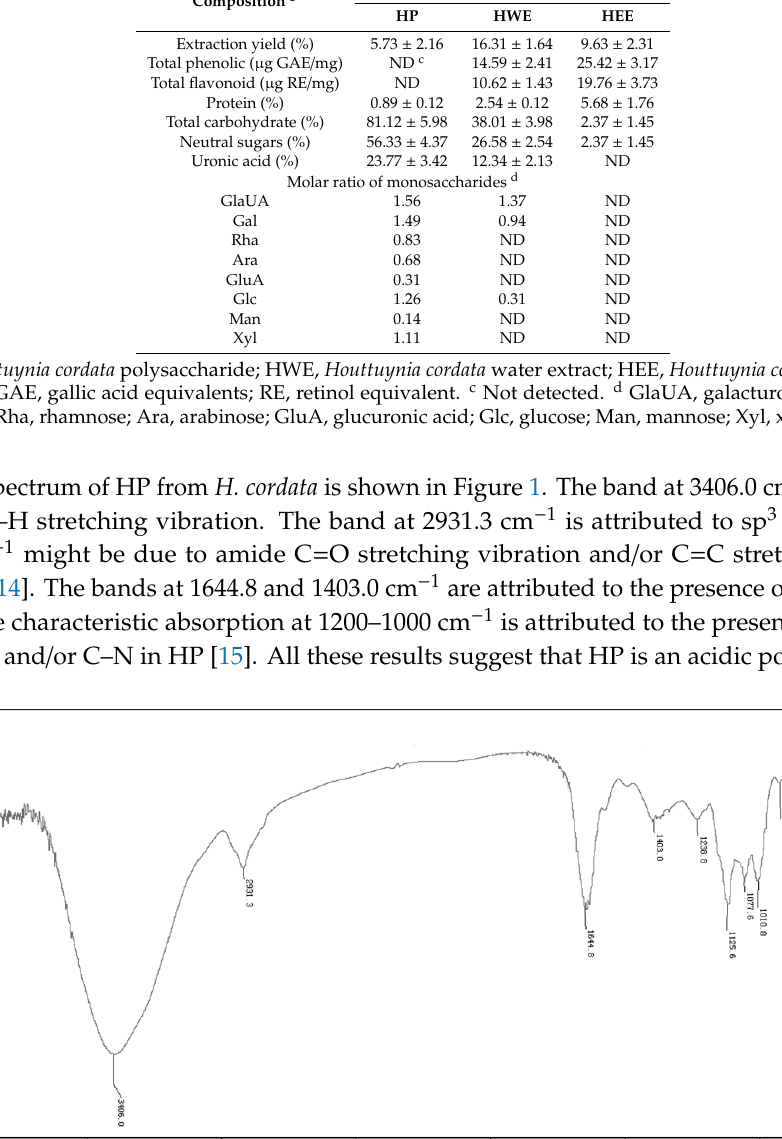
Table 1. Yields and chemical composition of Houttuynia cordata extracts HP, HWE, and HEE a . Extract / Fraction Composition b HP HWE HEE